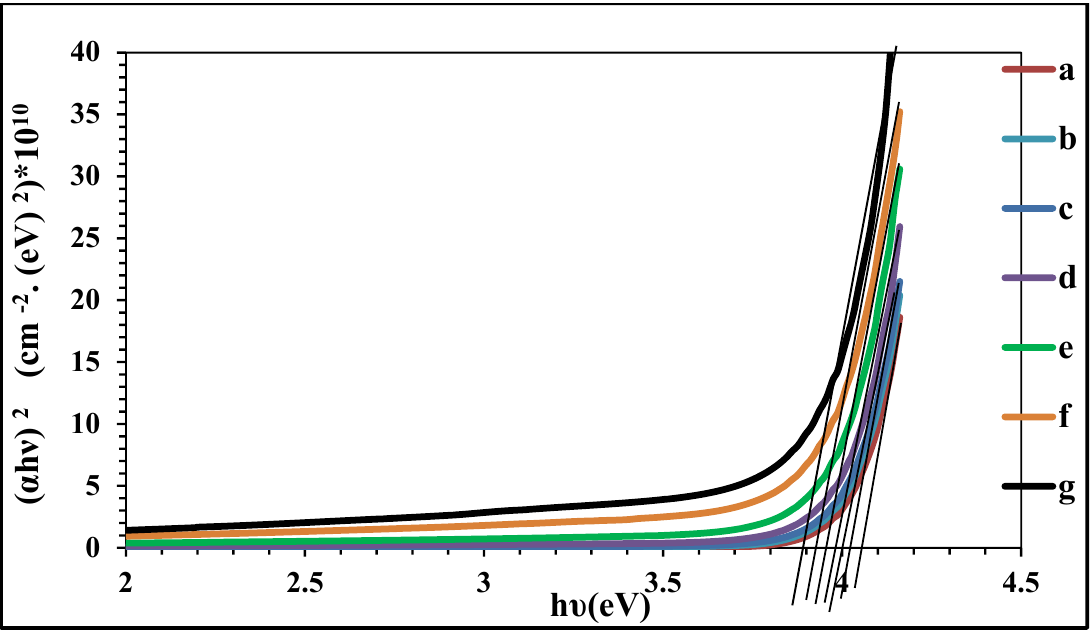
Fig .6: Direct transition band optical energy gap solid films of PVA\CuI composites with different concentrations of CuI. (a) 0wt% (b)1wt% (c)3wt% (d)5wt% (e)7wt% (f)9wt%